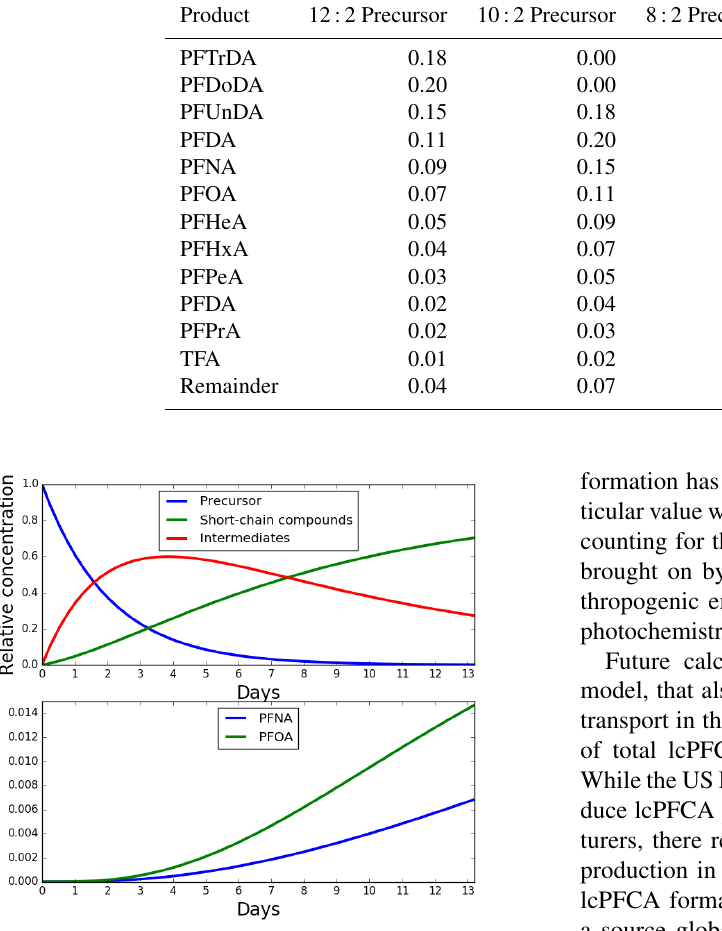
Figure 6. Fluorotelomer precursor chemical fate along HYSPLIT trajectory through summertime photochemical environments. After two weeks, yields of PFOA and PFNA are approximately 1.5 and 0.7%, respectively, with more than 20% of the initial precursor still in an intermediate form which will undergo further